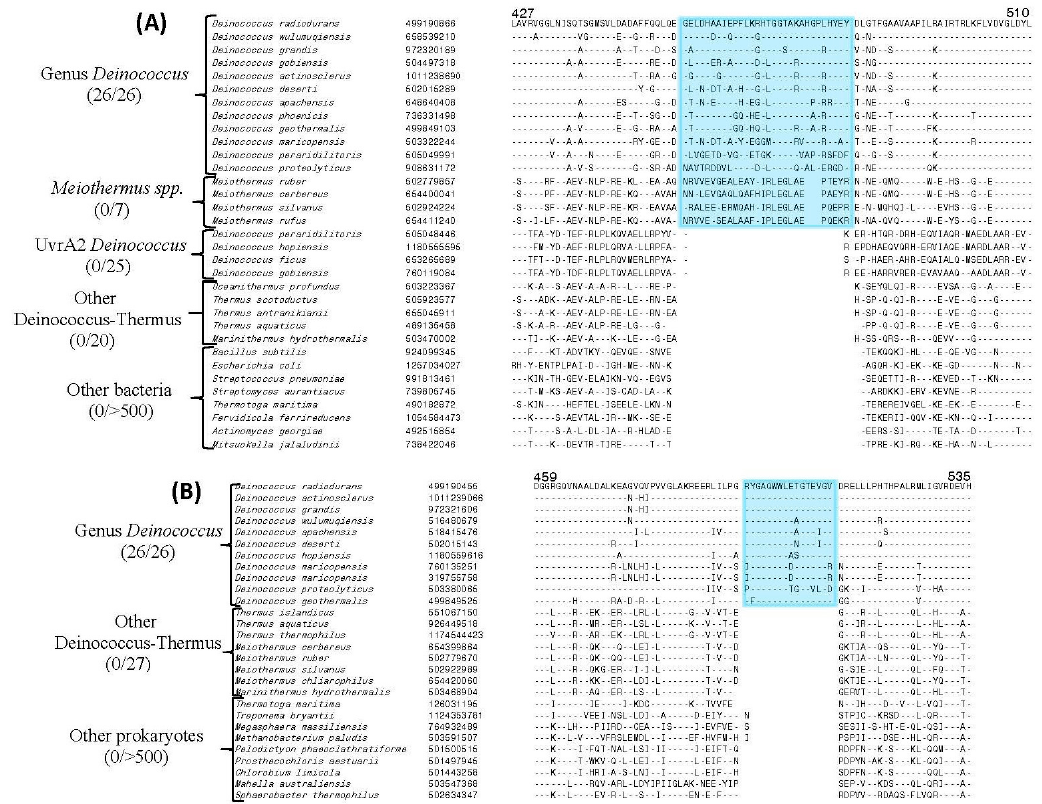
Figure 1. Conserved signature indels in the UvrA1 and UvrC proteins that are specific for the Deinococcus homologs. ( A ) Partial sequence alignment of the UvrA protein showing a 30 amino acid insertion in a conserved region that is uniquely shared by the UvrA1 homologs from all 26 genome-sequenced Deinococcus species including Deinococcus aerius. This insert is not shared by the UvrA2 homologs of Deinococcus spp. but a shorter unrelated insert in this position is present in Meiothermus spp.; ( B ) Excerpts from the sequence alignment of UvrC protein showing a 16 amino acid insertion that is specific for Deinococcus homologs. The dashes (–) in these as well as other sequence alignments indicate identity with the amino acid present on the top line. The numbers on the top indicate the location of the sequence in the Deinococcus radiodurans protein.